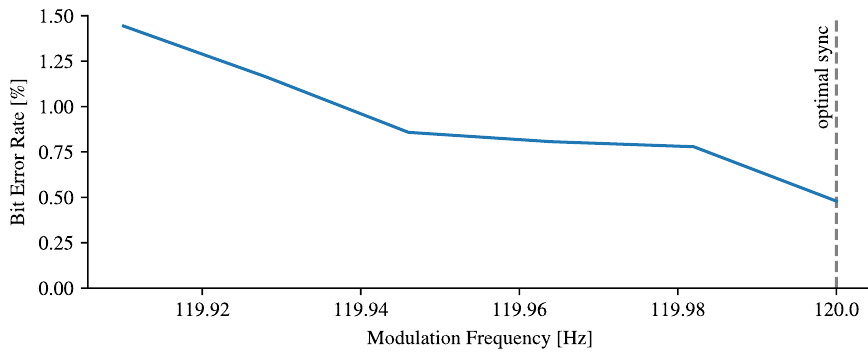
Figure 17. BER depending on accuracy of loose synchronization.